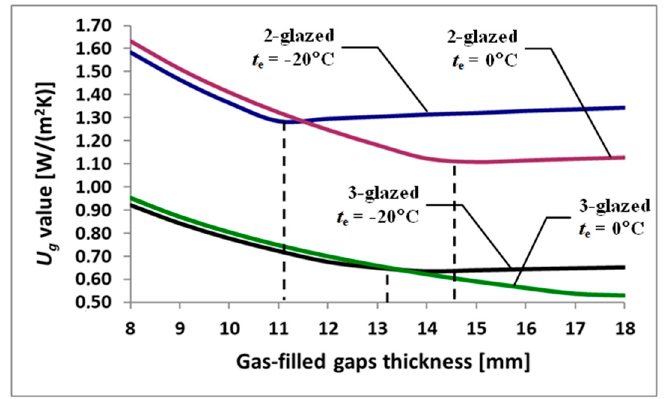
Figure 4. The dependence of the U g - values of IGUs on the thickness of the gaps.